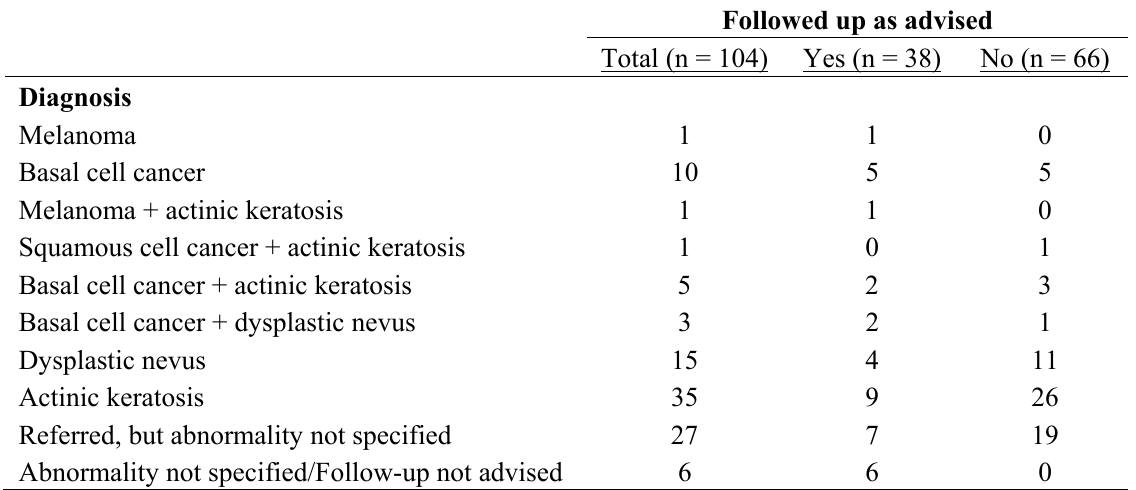
Table 2. Presumptive diagnosis and whether follow-up was as advised among individuals whose skin examination revealed an abnormal